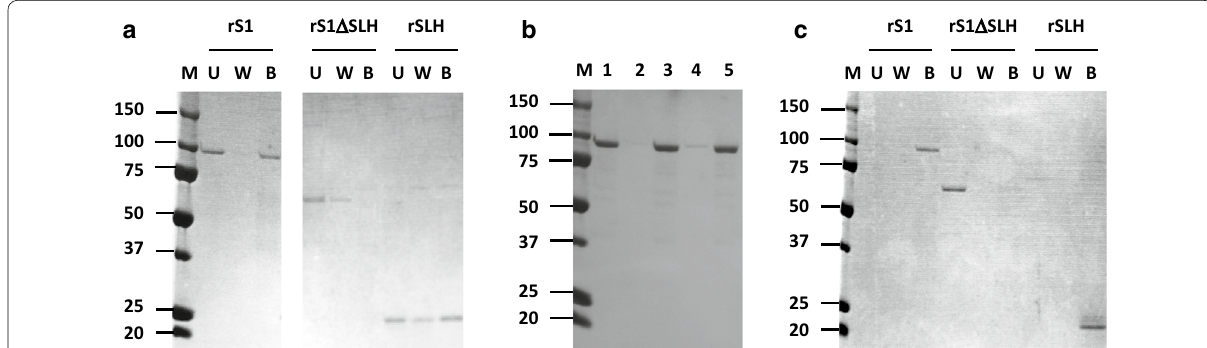
Fig. 4 Binding properties of rS1 and its truncated derivatives. Binding to microcrystalline cellulose ( a ), other polysaccharides, such as insoluble xylan and chitin ( b ), and the bacterial peptidoglycan layer ( c ), as revealed by SDS-PAGE. Each recombinant protein was incubated with microcrystalline cellulose, another polysaccharide or the peptidoglycan layer for 4 h at 30 °C. Unbound (lane U) and bound (lane B) protein fractions were separated by centrifugation; pellets were washed three times (lane W). b Lane 1, binding fraction of microcrystalline cellulose; lane 2, binding fraction of acid swollen cellulose; lane 3, binding fraction of insoluble birchwood xylan; lane 4, binding fraction of arabinan; lane 5, binding fraction of chitin. Lane M, molecular mass markers (kDa). Lanes U, W, and B of rS1 ( a ) are from an SDS-PAGE gel. Lanes U, W and B of rS1ΔSLH and rSLH were cropped from different SDS-PAGE gels, respectively